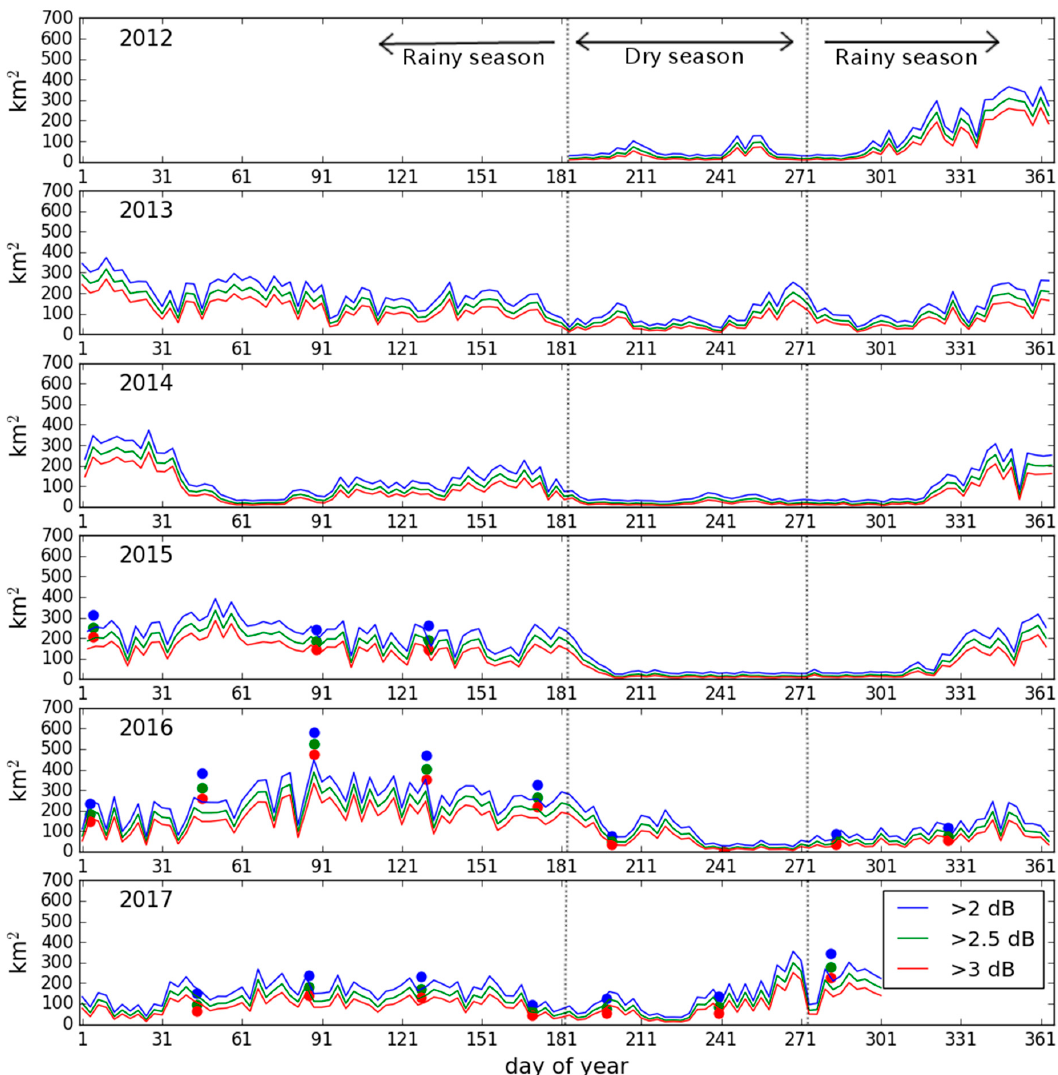
Figure 7. Time series of changes in the area of possible seasonal wetlands, delineated by the difference between a reference image for the smallest water extent (29 August 2016) and the predicted images of PALSAR-2 HH σ 0 . Red: reference σ 0 − predicted σ 0 > 3 dB; green: reference σ 0 − predicted σ 0 > 2.5 dB; blue: reference σ 0 − predicted σ 0 > 2 dB. The colored points are calculated from the original (i.e., not the predicted) PALSAR-2 HH σ 0 .